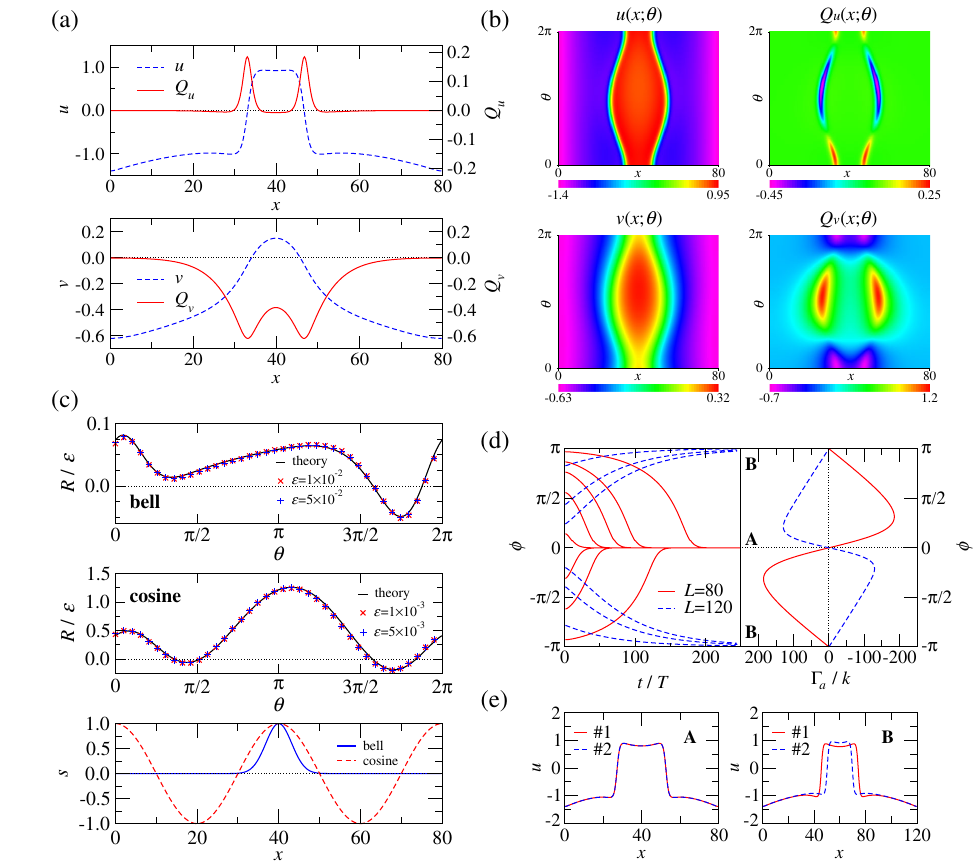
FIG. 2. Oscillating spots. The system is a 1D interval of length L ¼ 80 or L ¼ 120 with no-flux boundary conditions. The parameter α is space dependent; i.e., α ð x Þ ¼ α 0 þ ð α 1 − α 0 Þð 2 x=L − 1 Þ 2 with α 0 ¼ − 1 . 1 and α 1 ¼ − 1 . 6 so that α is the largest at the center ( x ¼ L= 2 ) and the smallest at the boundaries ( x ¼ 0 , L ). Other parameter values are τ − 1 ¼ 0 . 03 , γ ¼ 2 . 0 , κ ¼ 1 , and δ ¼ 2 . 5 . With these conditions, an oscillating spot constrained at the center can be generated. The oscillation period is T ¼ 194 . 8 ( L ¼ 80 ) or T ¼ 204 . 0 ( L ¼ 120 ). (a) Snapshots of the oscillating spot solution X 0 ð x Þ ¼ ½ u ð x Þ ; v ð x Þ(cid:1) and the corresponding phase-sensitivity function Q ð x Þ ¼ ½ Q u ð x Þ ; Q v ð x Þ(cid:1) for θ ¼ 0 . (b) Evolution of X 0 ð x ; θ Þ and Q ð x ; θ Þ during 0 ≤ θ < 2 π . (c) Phase-response curves R ð θ Þ of the oscillating spot normalized by the stimulus intensity ε . Perturbation s ð x Þ is either bell-shaped [ s ð x Þ ¼ ε exp f − 4 ð x − L= 2 Þ 2 =L g ] or sinusoidal [ s ð x Þ ¼ ε cos ð 4 π x=L Þ ] and is given to the activator ( u ) component. Results obtained by direct numerical simulations with two different values of ε are compared with the theory, R ð θ Þ ¼ h Q ð x ; θ Þ ; s ð x Þi , where the inner product is taken over the 1D interval ( 0 ≤ x ≤ L ). (d) Evolution of phase differences between two systems coupled through the u component with the intensity matrix K ¼ diag ð k; 0 Þ with k ¼ 10 − 4 , showing in-phase synchronization for L ¼ 80 (A) and antiphase synchronization for L ¼ 120 (B). Different lines show the evolution of ϕ for different initial conditions. The antisymmetric part of the phase-coupling function Γ a ð ϕ Þ (rescaled by the coupling intensity k ) is shown for comparison. (e) Snapshots of activator patterns u ð x Þ of both systems in the in-phase (A) and antiphase (B) synchronized